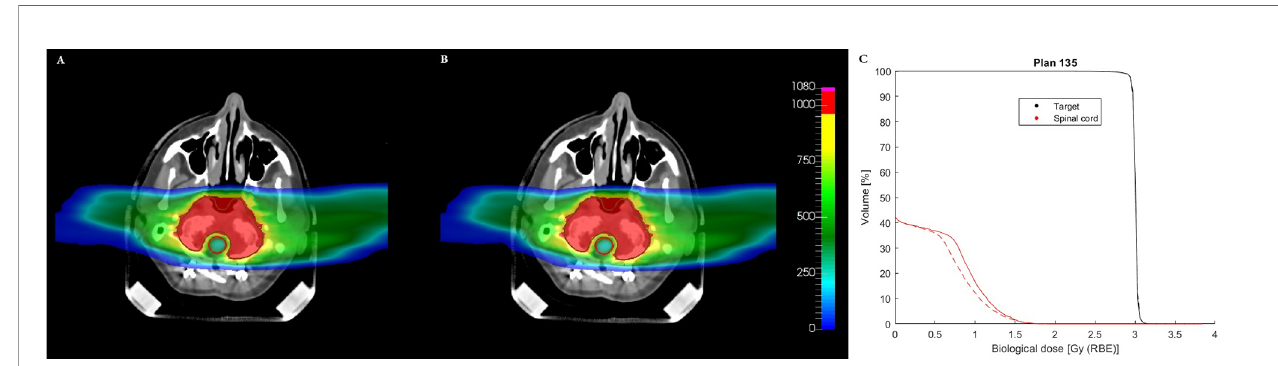
FIGURE 4 | Comparison of dose distributions on a CT slice for patient plan 135, obtained with (A) voxel-dose-based and (B) gEUD-based optimization. The target (brown contour) and the spinal cord (red contour) are shown. The dose levels are plotted in per mil of the prescribed dose. (C) Comparison of DVHs obtained with voxel- dose-based (solid line) and gEUD-based (dashed line) optimization for patient plan 135. gEUD, generalized equivalent uniform dose; DVH, dose –